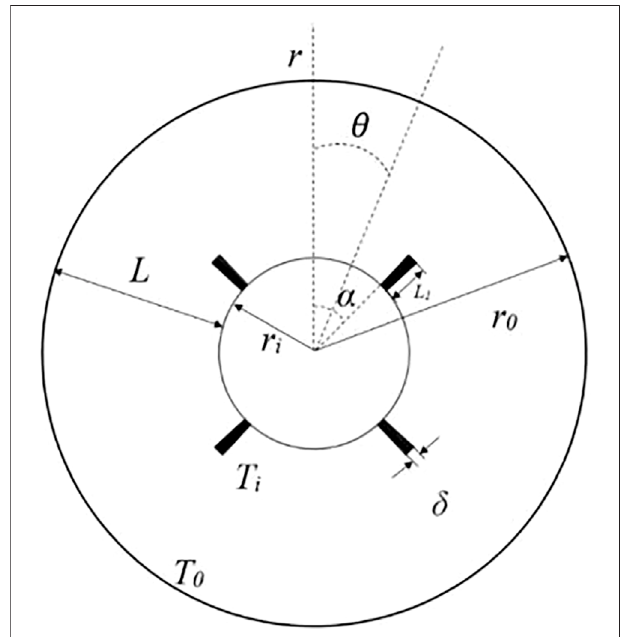
FIGURE 1 | Schematic diagram of annuli with fi